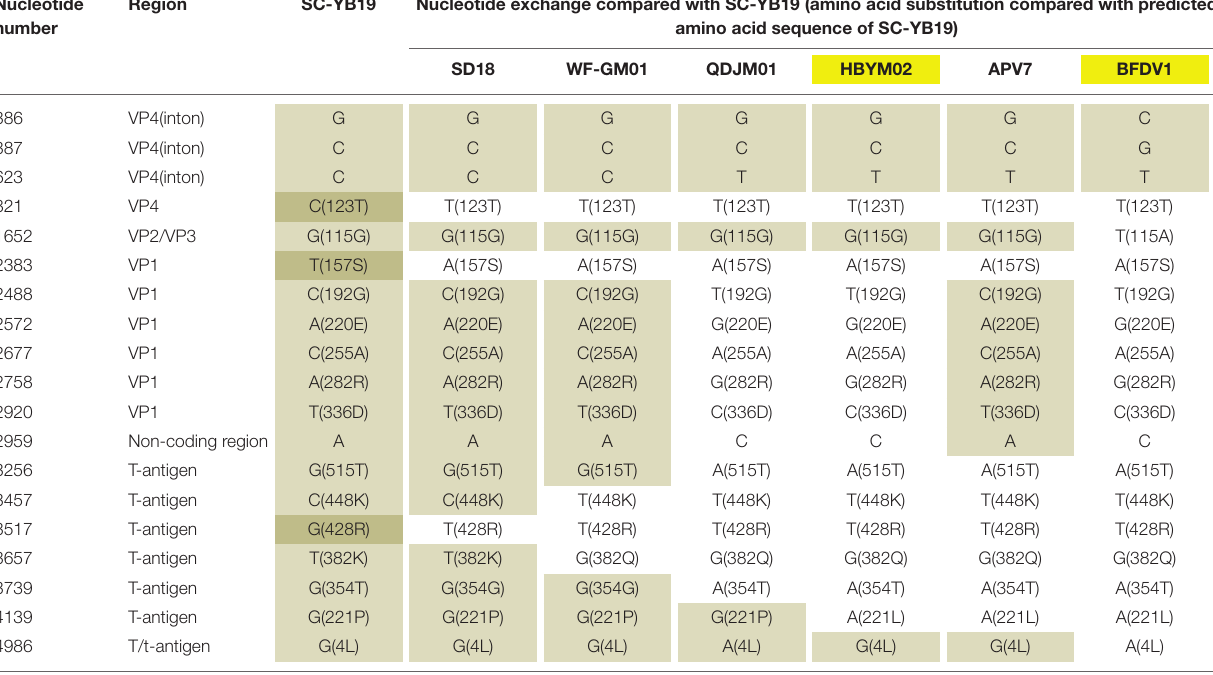
TABLE 1 | Point mutations in seven strains of BFDVs compared with SC-YB19. Nucleotide number